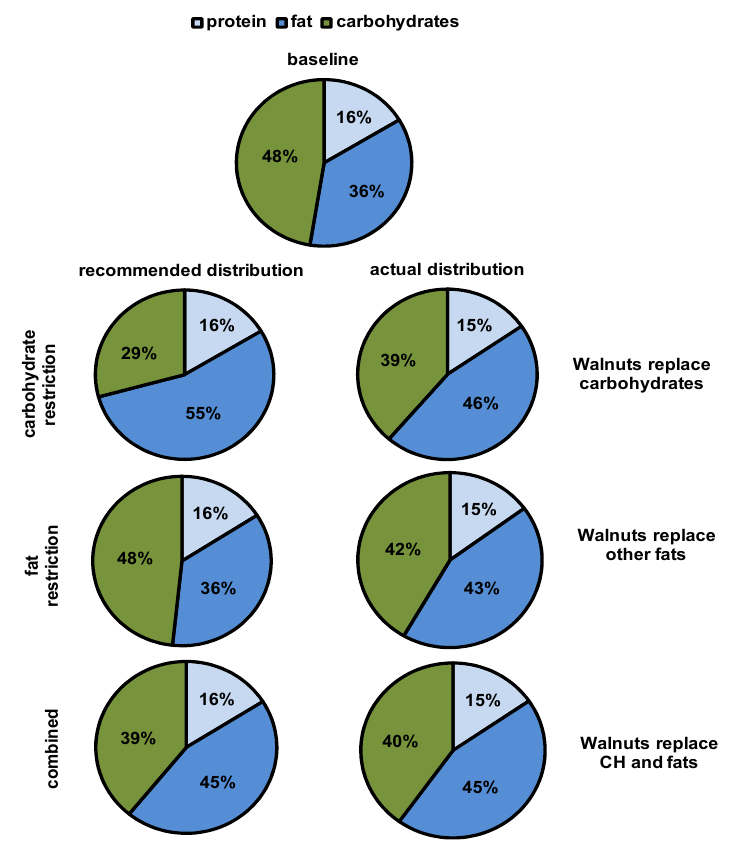
Figure 5. Adherence to recommended macronutrient replacement during walnut consumption. Percentage of daily total calories at baseline, as well as the recommended and the actual distribution of calories, were calculated by analyzing dietary reports.